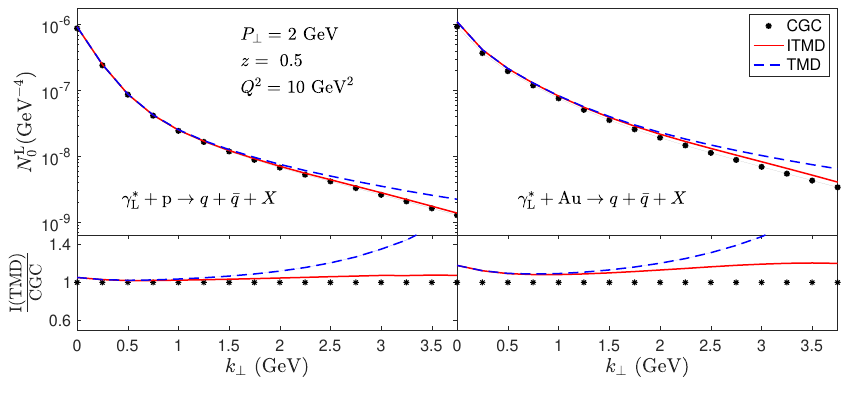
and φ k ) for production of ⊥ ⊥